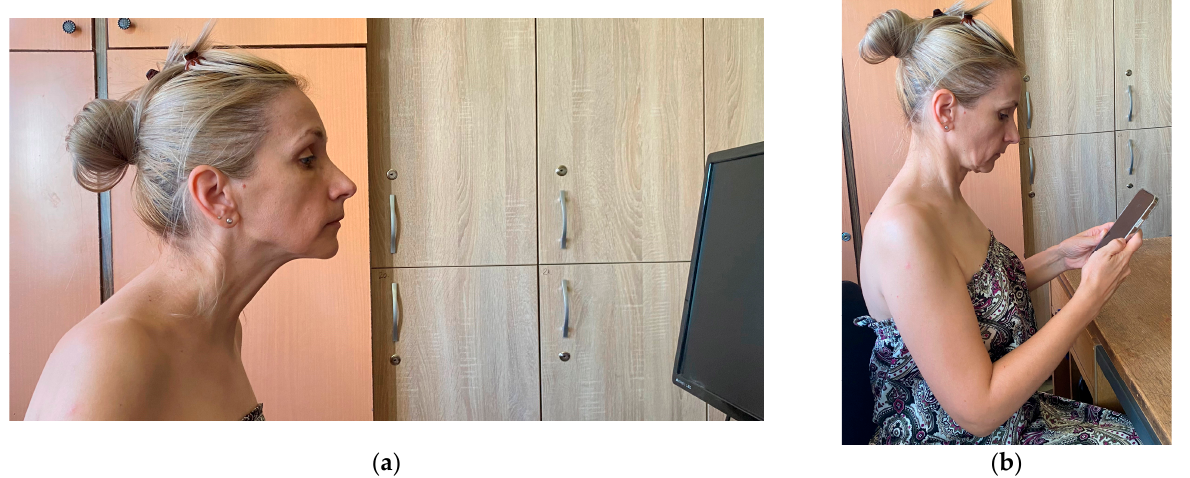
Figure 1. ( a ) Forward head posture (FHP), which is sometimes called the desktop neck posture; ( b ) text neck posture (TNP)—examples given by one of the examiners in the study.